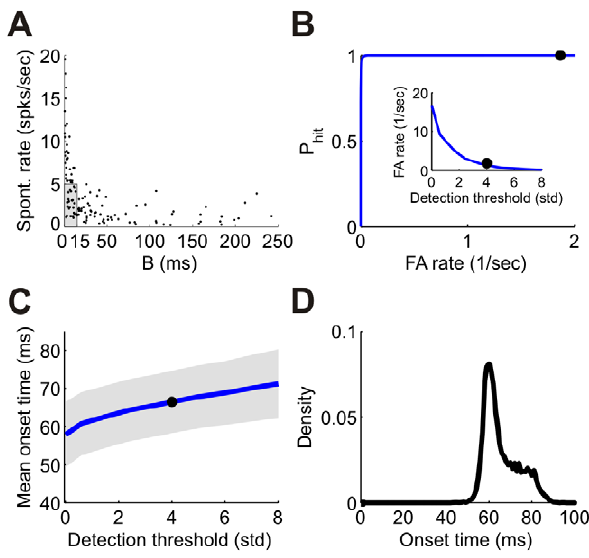
Figure 4. Onset detection. (A) Mean spontaneous firing rate vs. the modulation amplitude, B , of the first spike latency tuning curves. Each point corresponds to a single neuron. All neurons in this figure were taken from the same dataset (dataset 3 in Table 1). Neurons were categorized as onset detectors if the modulation was smaller than 15 ms and the spontaneous rate was below 5 spks/sec (shaded box in the lower left corner, 25 cells). (B) ‘ROC’ curve of the onset detection mechanism for a time window of 20 ms. The inset shows the false alarm rate as a function of detection threshold in standard deviations. (C) Mean onset time as a function of detection threshold. The gray band represents 6 1 standard deviation. The black circles in (B) and (C) mark the detection threshold of 4 standard deviations above baseline, which we use throughout the paper. (D) Distribution of onset times. The number of spikes was required to be 4 standard deviations above the mean number of spikes in a 20 ms window during spontaneous firing.